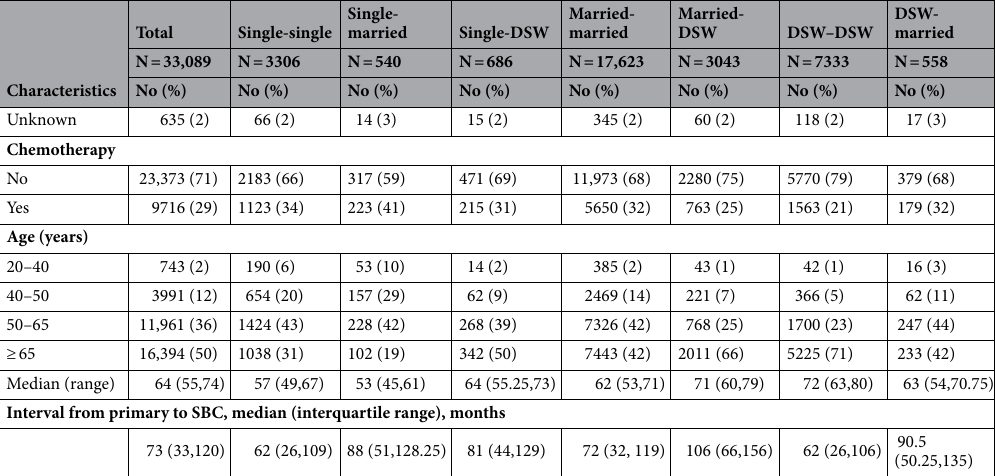
Table 1. Baseline demographic and tumor characteristics of patients according to marital status in SEER database.